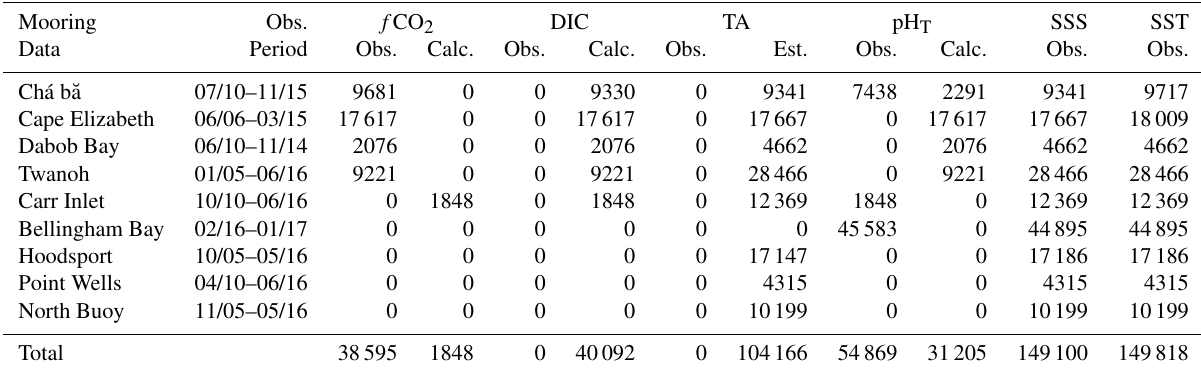
Table 4. Mooring datasets incorporated into the analysis. The observing period and number of f CO 2 , DIC, TA, pH, SSS, and SST values that were observed (Obs.), calculated (Calc.), and estimated (Est.) are provided. Mooring Obs. f CO 2 DIC TA pH T SST Data Period Obs. Calc. Obs. Calc. Obs. Est.